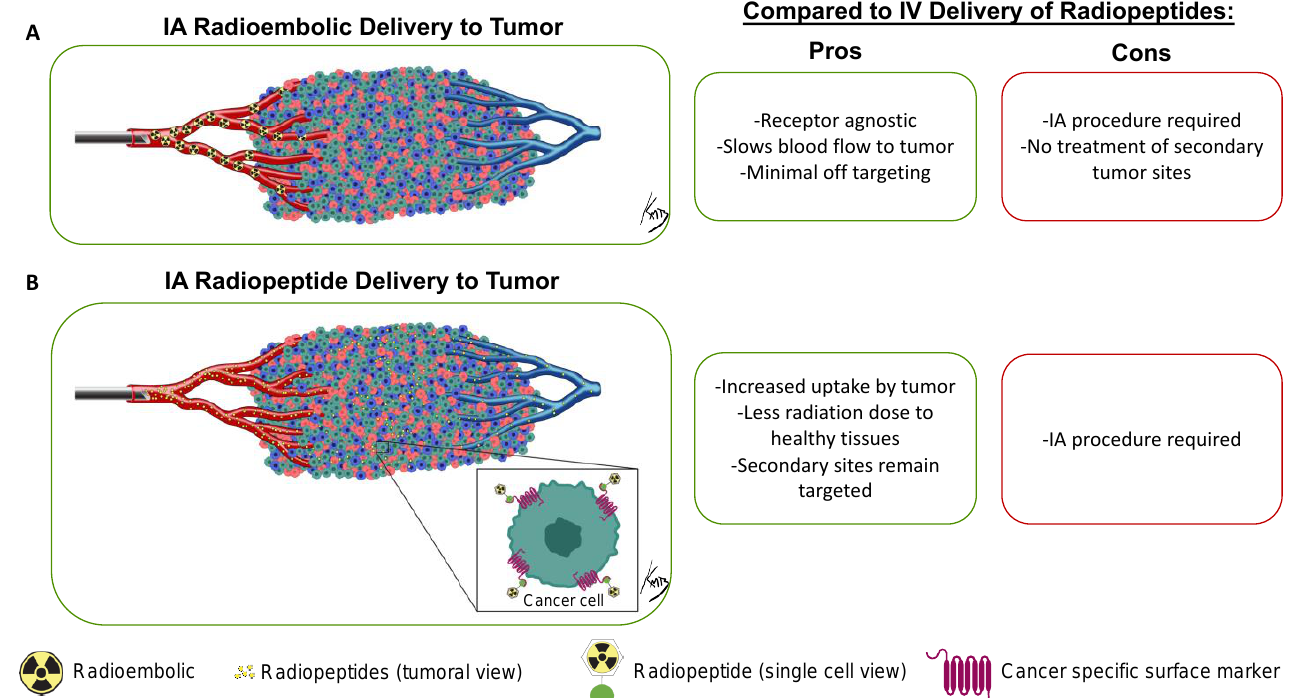
Figure 3. Overview of the IA delivery paradigm of radioembolics and radiopeptides. The radioembolic ( A ) becomes lodged in the smaller arterial vessels and will not cross over into the venous system. Conversely, radiopeptides ( B ) will enter the tumor space and bind to specific cancer receptors. Not all radiopeptides will be retained in the tumor and will instead travel systemically through the venous system. This allows for a higher accumulation of the radiopeptide in the tumor while still giving a systemic dose for satellite tumor-site treatment. In the tumor diagram, green cells are tumor cells expressing the specific marker, while red and blue cells are non-targeted tumor microenvironment cells. Figure 3 tumor vasculature: © Kevin Brennan 2023.